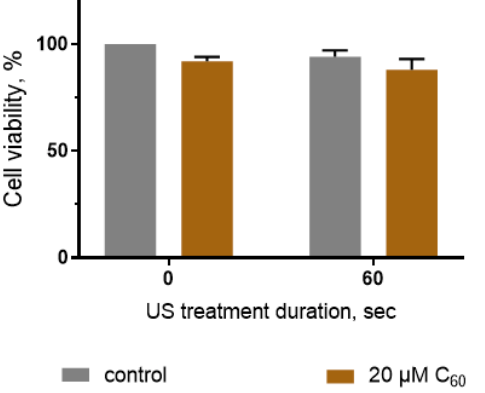
Figure 5. Viability of HEL 299 cells, incubated in the presence of 20 µM C 60 and treated with 1 MHz ultrasound (US).